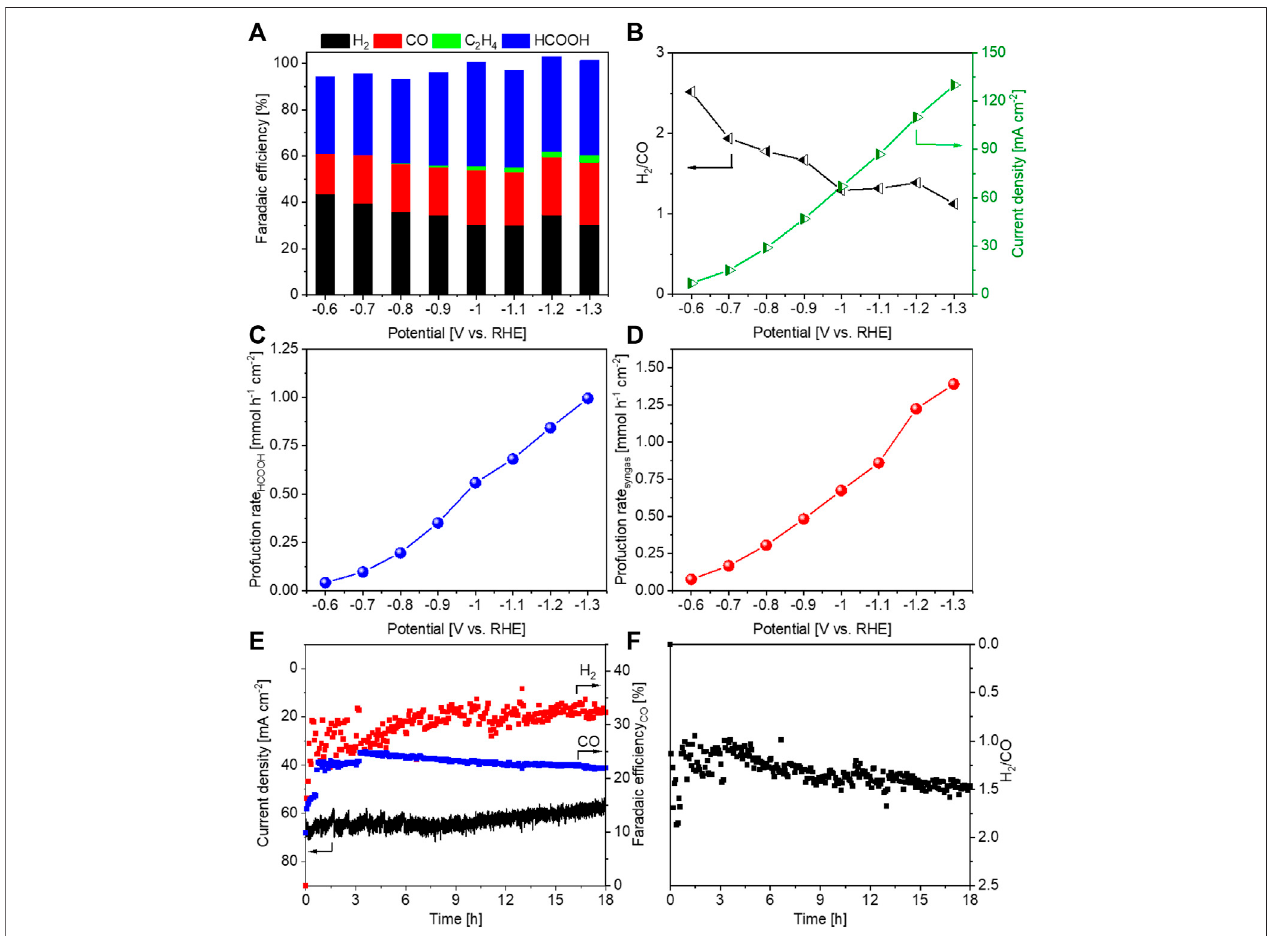
FIGURE 7 | Sample Cu 2 O-Al-3 tested in a fl ow cell with 2.0 M KHCO 3 electrolyte. (A) FE values for main products, (B) H 2 /CO ratios of syngas and geometric current densities, (C) production rate of HCOOH, (D) production rate of syngas, (E) a stability test and (F) H 2 /CO ratios of syngas during the stability test.